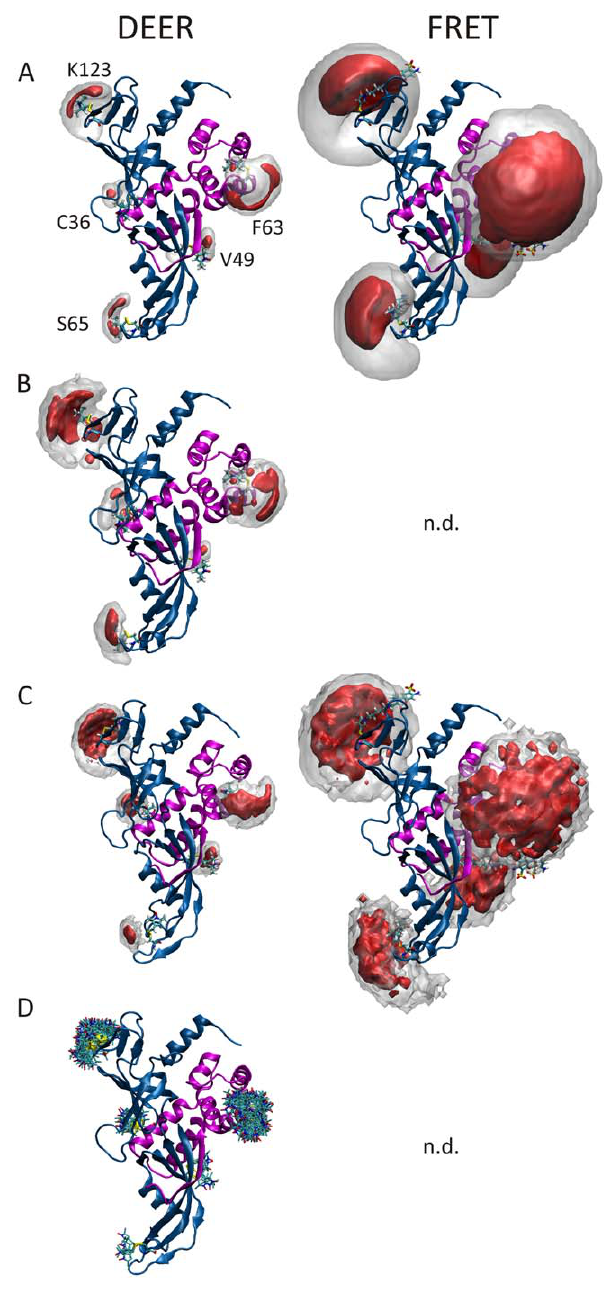
Figure 8. Label orientation probability distributions. deduced from in vacuo MD simulations (A), in aqua MD simulations (B) and MC sampling (C) in Rpo4/7 (as magenta/blue ribbons). Clouds envelope 99.5% (gray) and 50% (red) of the total probability. Rotamers (D, depicted as sticks) calculated from a given rotamer library [29] span 99.5% of the population. In aqua MD simulations have not been performed for the fluorophore labels as they are currently computa- tionally to intensive for standard hardware. A pre-calculated FRET-label rotamer library is currently not available. doi:10.1371/journal.pone.0039492.g008 FRET distances to structural models. For the simulation of spin label side chains, highly optimized, semi-empirical approaches like the RLA provide efficient means to predict DEER distance data. These results should encourage a more quantitative use of